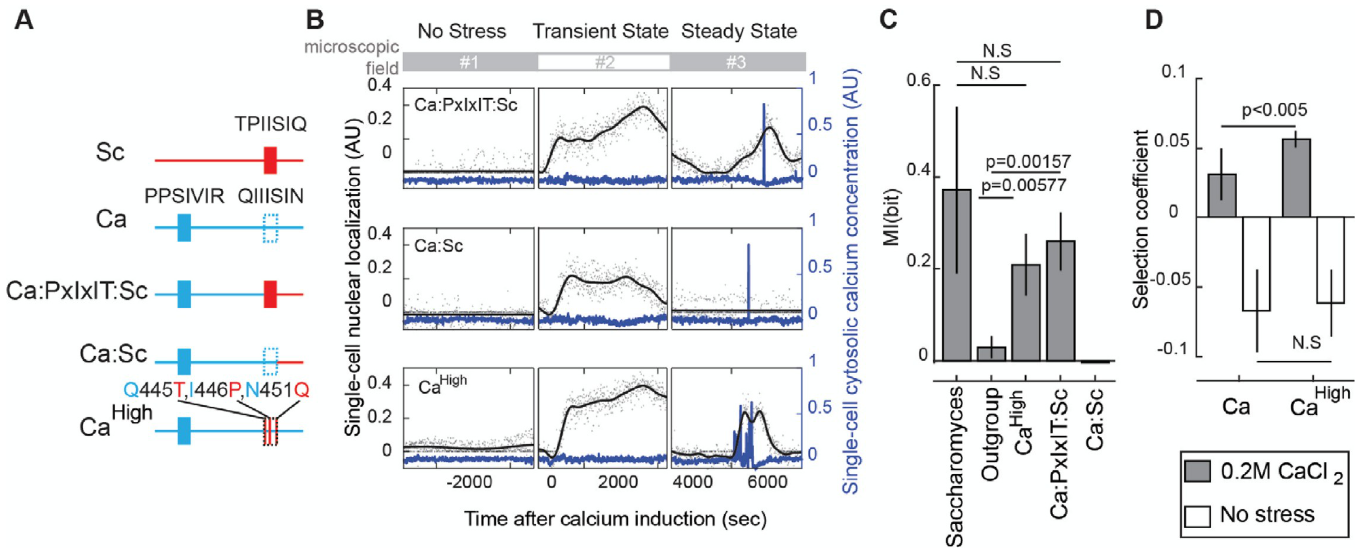
Fig 5. The S . cerevisiae PxIxIT strength in the specific part of IDR is sufficient for the C . albicans IDR to show a pulsing phenotype and improve fitness under 0.2M calcium stress. A) A schematic diagram of the PxIxIT sites on orthologous and chimeric IDRs. Sc: S . cerevisiae IDR; Ca: C . albicans IDR; Ca:PxIxIT:Sc: chimeric IDR of the N-terminal region of the C . albicans IDR (a.a. #1 to 444) and the C-terminal region of the S . cerevisiae IDR including PxIxIT site (a.a. #330 to 568); Ca:Sc: chimeric IDR of the N-terminal region of the C . albicans IDR (a.a. #1 to 451) and the C-terminal region of the S . cerevisiae IDR excluding PxIxIT site (a.a. #337 to 568); Ca High : C . albicans IDR with three point-mutations (Q445T, I446P, N451Q). B) Representative single-cell trajectories of cytosolic calcium concentration (blue lines) and nuclear localization (black lines), which are the Gaussian Process regression based on 600 time-points (black dots). Plots are broken to indicate when each trajectory composites a different cell from a different microscope field. C) Averaged mutual information between the calcium burst and the dynamics of pulsing reporters. P-values indicated are from a two-tail two-sample t-test. n = 7, 4, 3, 3, 1 experiments. Error bars represent 1.96 SE. D) The selection coefficient calculated from the competition assays under no stress or 0.2M calcium stress. n = 6 replicates for Ca and 16 replicates for Ca High with three cell lines. Error bars represent 1.96 SE. P-values indicated are from a two-tail two-sample t-test. AU: Arbitrary Units.